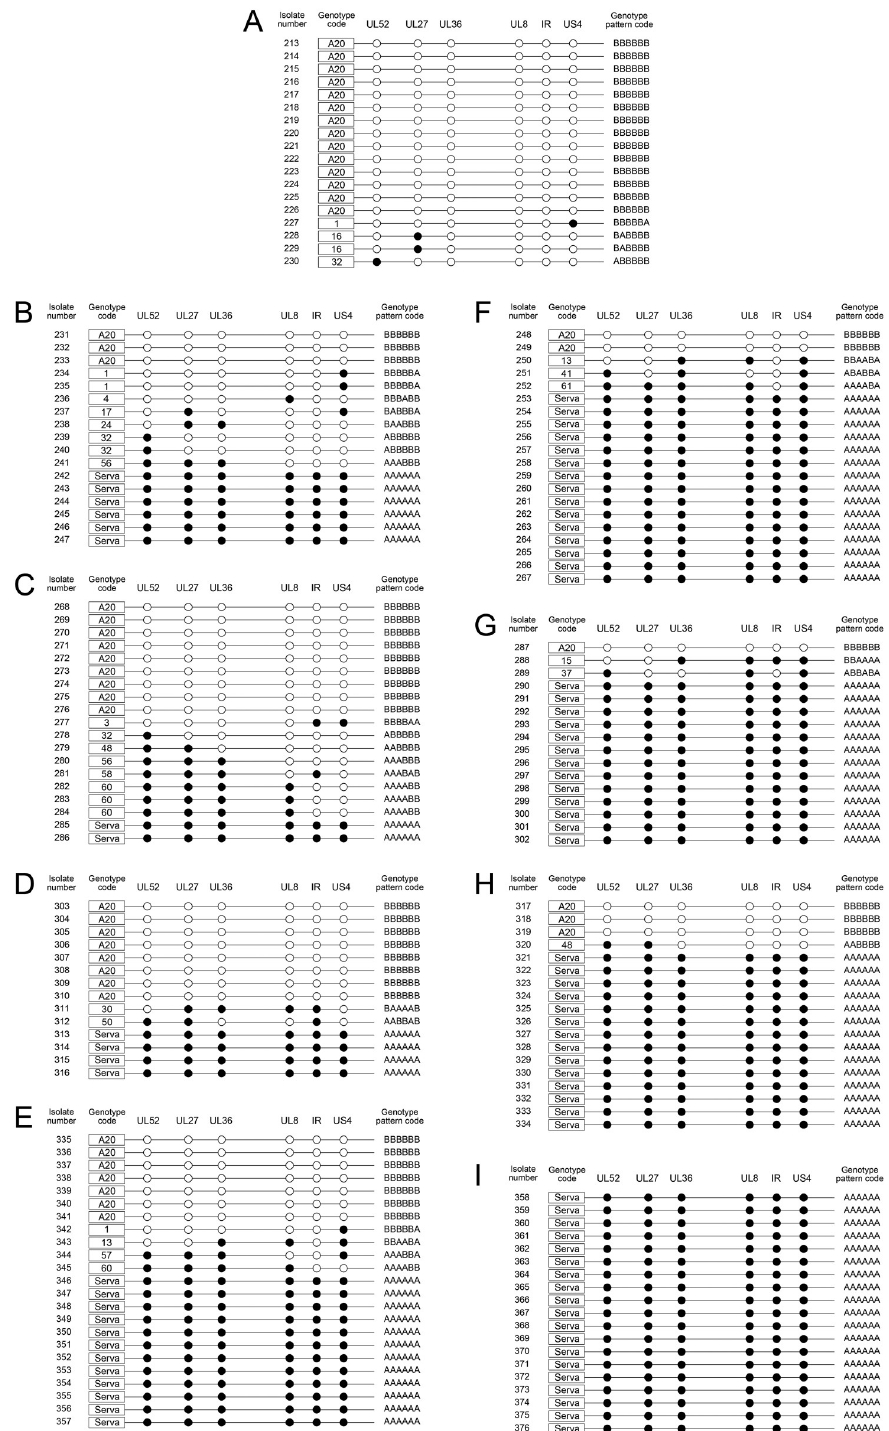
Fig 5. Schematic view of SNP distribution showing the composition of the progeny population collected from CEK cells (A) co-infected at a MOI of 5 with Serva and A20, or (B-I) superinfected with either Serva or A20. The left panels (B, C, D, E) show primary infection with Serva, while the right panels (F, G, H, I) show primary infection with A20. The incubation period between primary and secondary infection was 2 (B, F), 4 (C, G), 6 (D, H) or 8 (E, I) hours. The samples were collected at 72 hpi. The closed circles indicate Serva-like SNPs and open circles